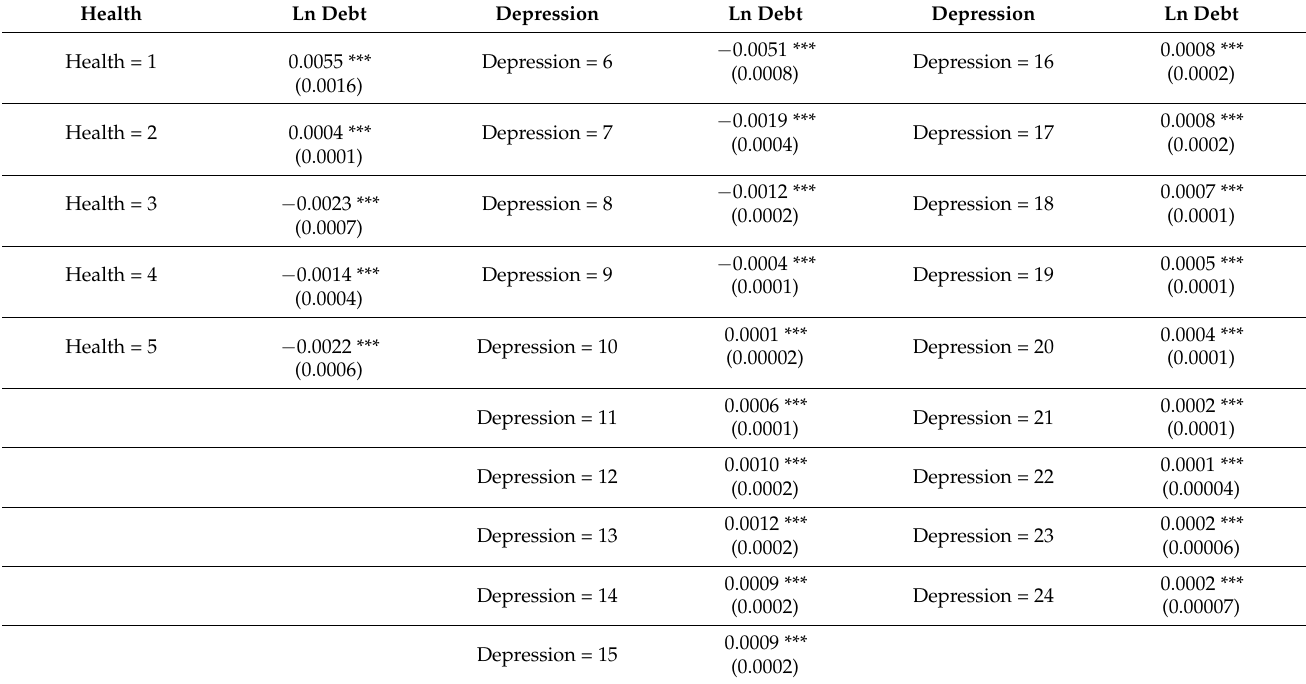
Table A1. Marginal effects of household debt in female subgroup.